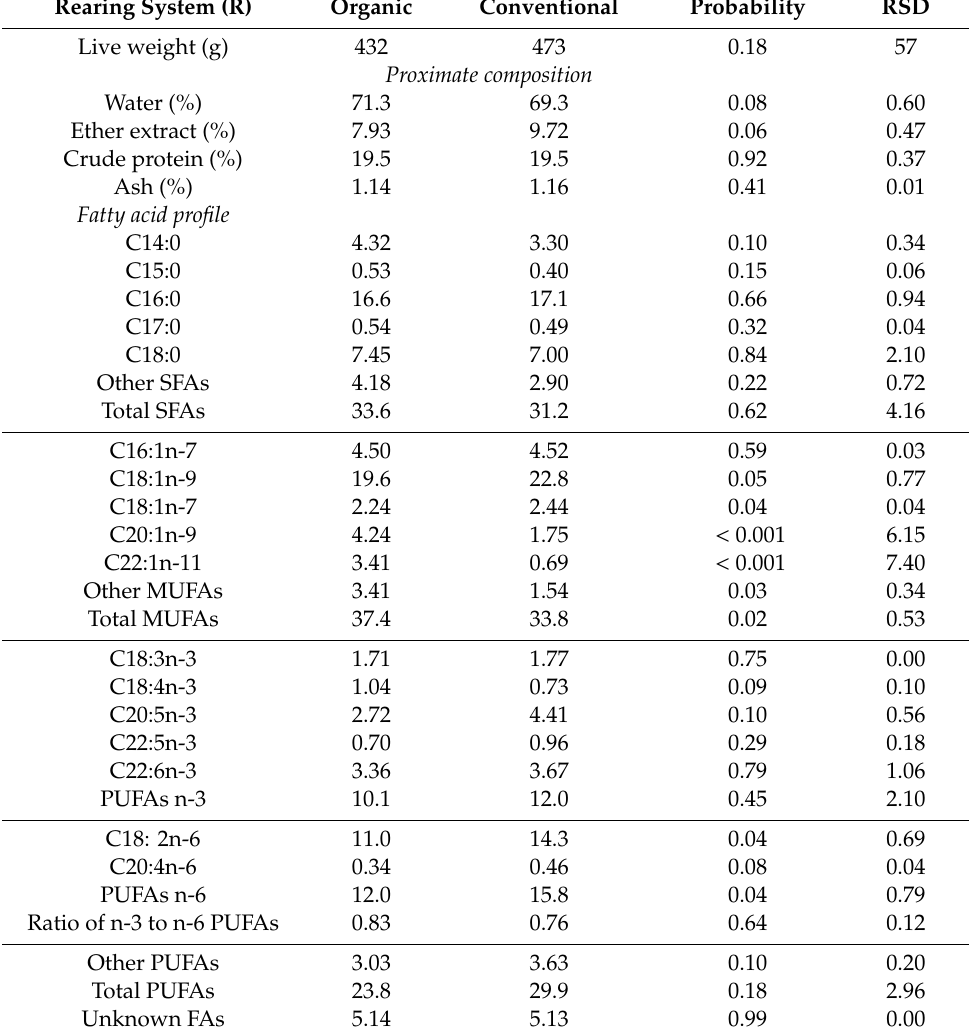
Table 2. Proximate composition (% as-fed) and fatty acid profile (% of total fatty acid methyl esters) of sea bass